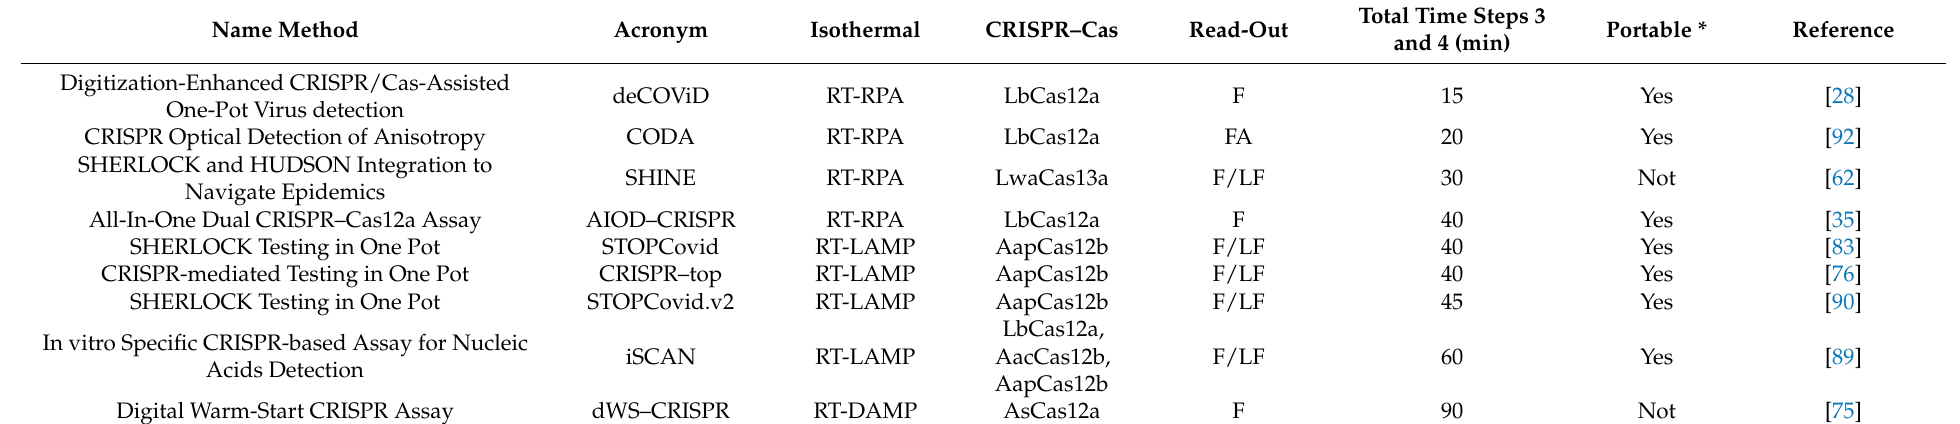
Table 3. List of one-pot CRISPR-based methods.